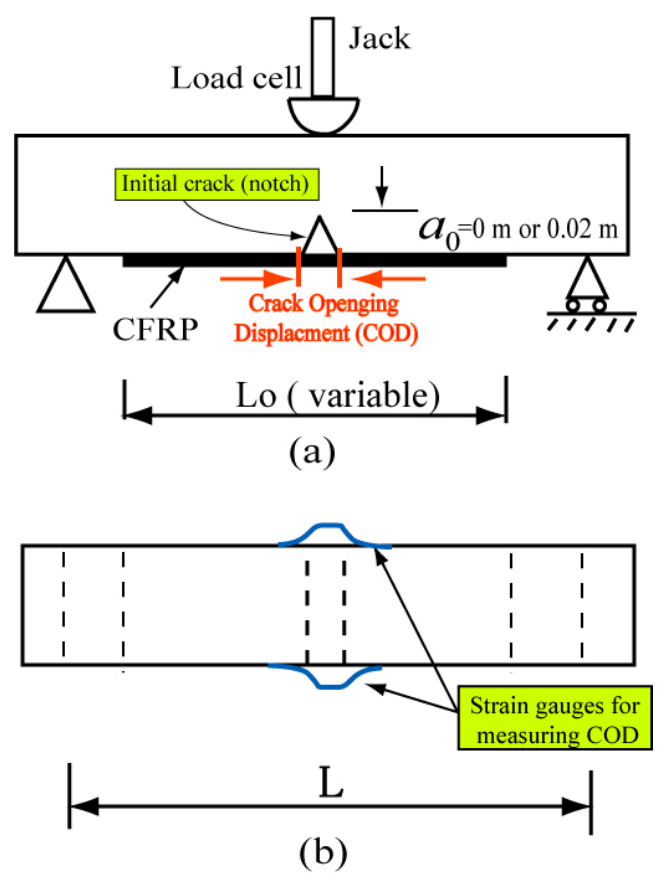
Figure 2. The test setup and locations of the strain gauges: ( a ) test setup; and ( b ) locations of strain gauges for measuring crack opening displacement